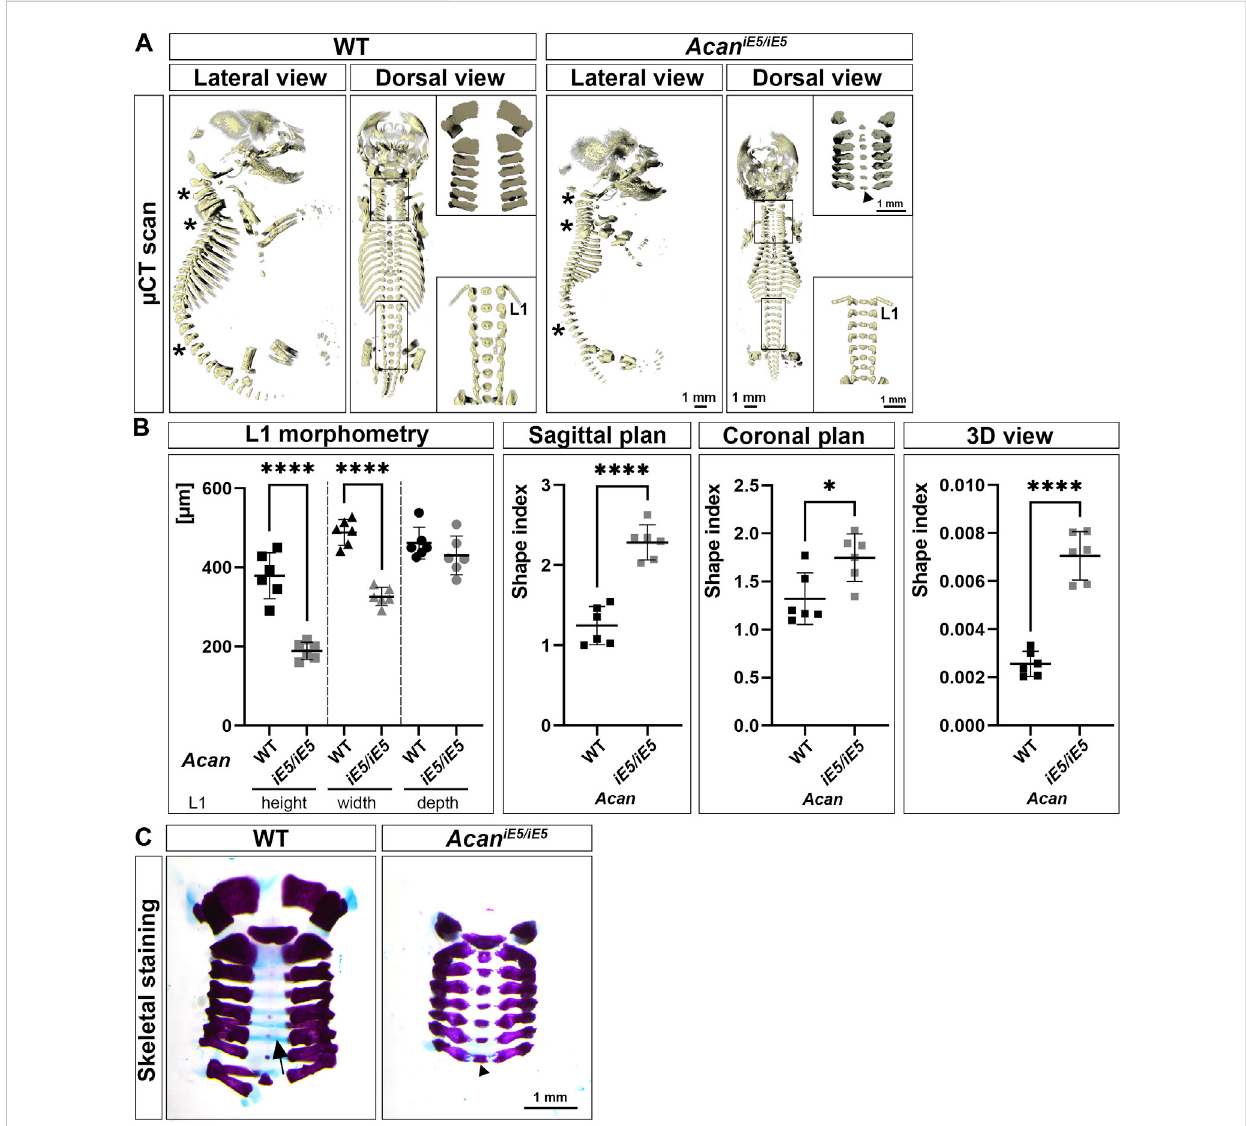
FIGURE 2 Characterization of skeletal abnormalities of aggrecan-de fi cient mice. (A) Representative 3D reconstruction of µ-CT scans of the sagittal and coronal views of the skeleton of E18.5 WT and Acan iE5/iE5 embryos. Asterisks depict the differences in spine alignment in between the genotypes. Upper and bottom inserts show the enlarged cervical and lumbar spinal regions, respectively. Arrowhead indicates premature ossi fi cation of the cervical vertebralbodiesinthemutant. (B) MorphometricanalysisoftheL1vertebra.2Dshapeindexofcoronalandsagittalviewsand3Dshapeindex.Values represents the mean ± STD. Statistical signi fi cance calculated by unpaired t -test test, where *: p ≤ 0.05 and ****: p < 0.0001. (C) Whole-mount skeletal staining of the isolated cervical region of E18.5 embryos, demonstrating the absence of staining for sGAG in Acan iE5/iE5 mice and the concomitant accelerated calci fi cation of the VB in mutant mice (arrowhead). Arrow shows the Alcian blue positive vertebral bodies in the wild type